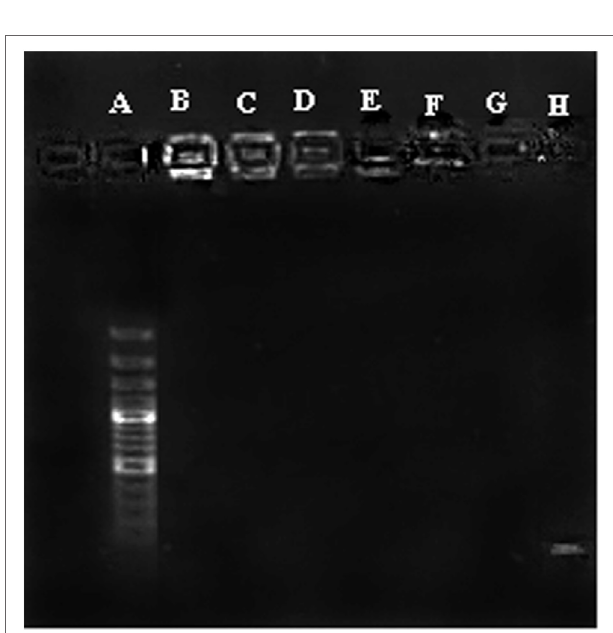
FigUre 3 | Agarose gel retardation assay of cationic poly(lactic-co-glycolic) acid (PLGA)/polyethylenimine (PEI) nanoparticles. A: Ladder, B–D: PLGA/PEI CP 2-4-6, E–G: PEI CP 2-4-6, H: cytosine–phosphorothioate–guanine oligodeoxynucleotide alone.